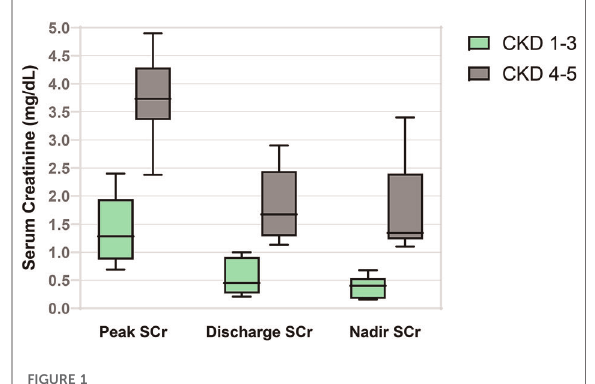
FIGURE 1 Early milestones in serum creatinine based on CKD stage at 1